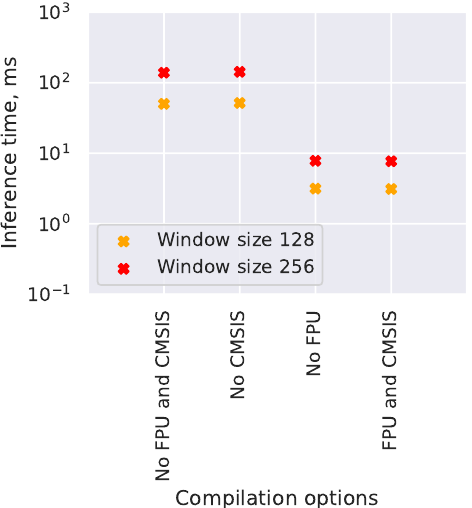
Figure 6. The impact of quantization on the performance of the custom CNN. Results on nRF5340. ( a ) Memory usage. ( b ) Inference time.